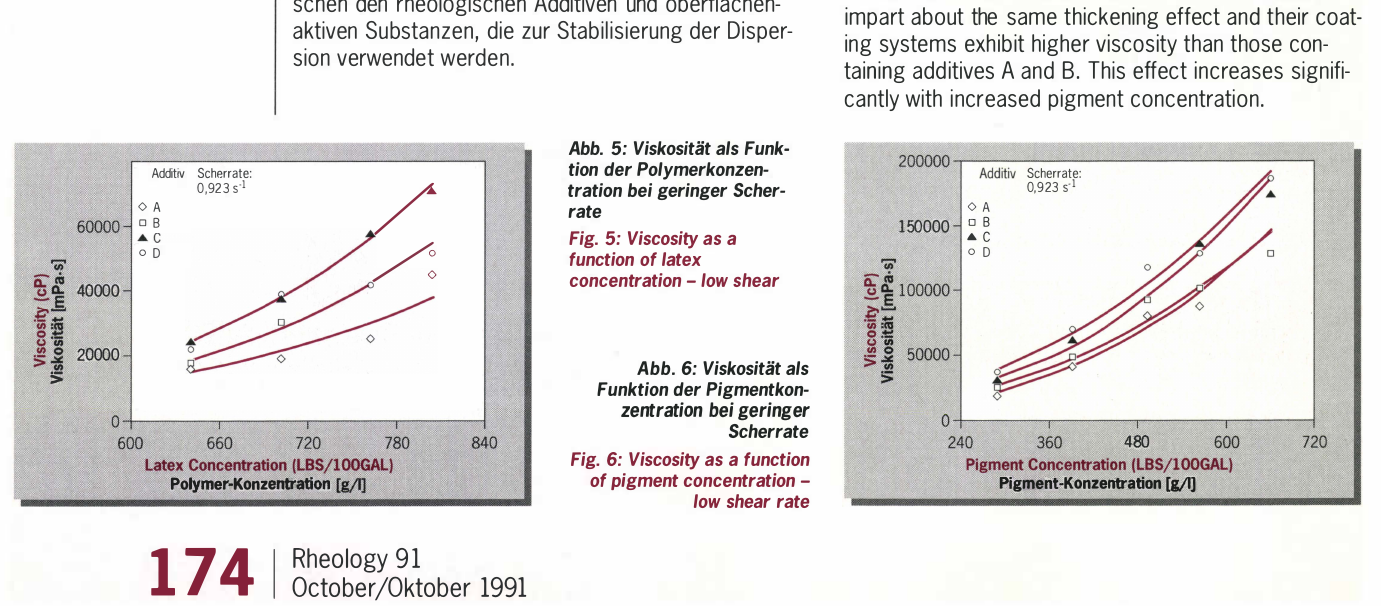
Fig. 5: Viscosity as a function of latex concentration -low shear